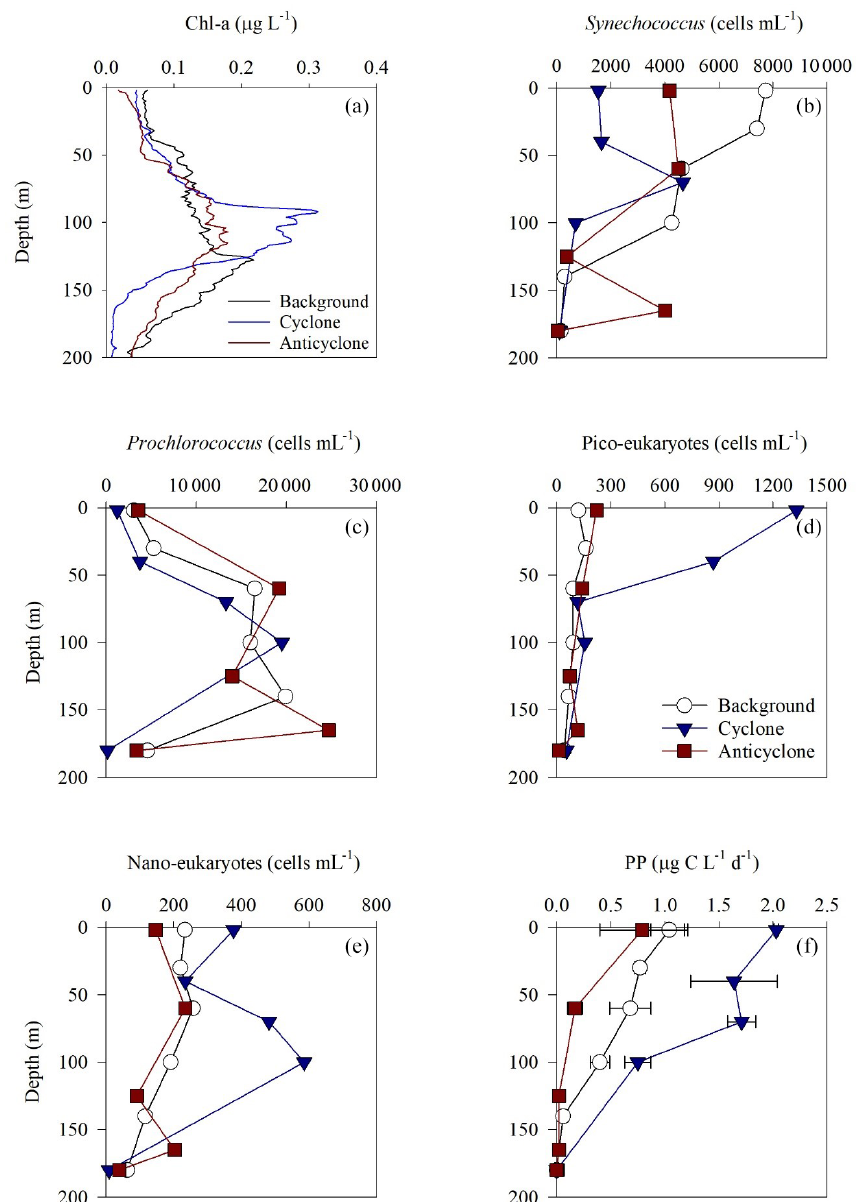
Figure 3. Vertical profile of chlorophyll a (a) , Synechococcus (b) , Prochlorococcus (c) , pico-eukaryotes (d) , nano-eukaryotes (e) and primary production rate (f) in the photic layer of cyclonic (blue triangle) and anticyclonic (red square) eddies and an uninfluenced background station (white circle) at the southeastern Mediterranean Sea during October